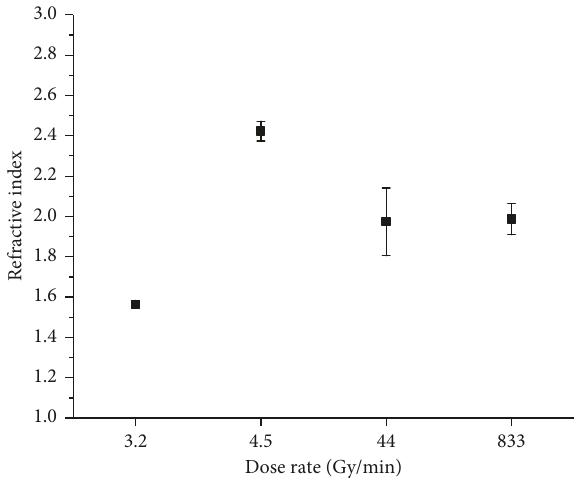
Figure 4: Refractive index changes show significant differences between all samples except between 44 and 833 Gy · min − 1 ( n � 3, p < 0 . 05, error displayed in standard